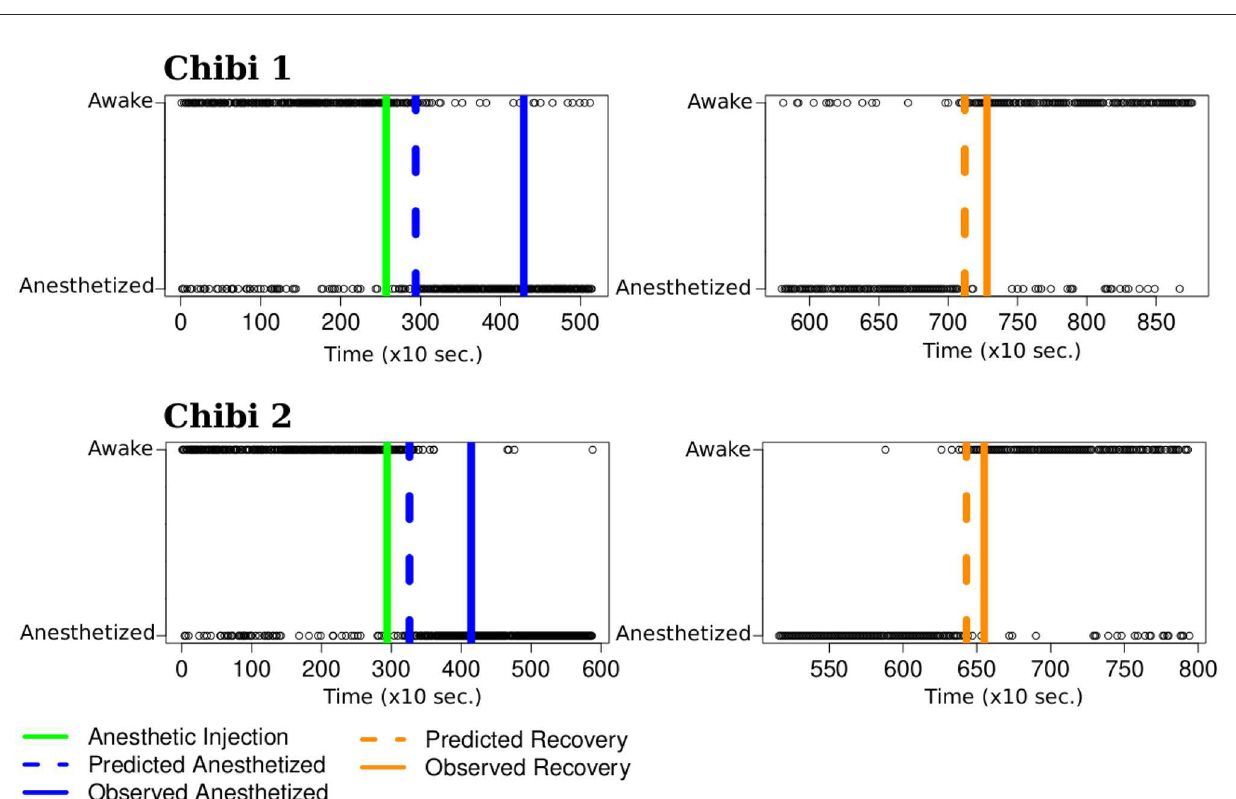
FIGURE6 Mental state transition time point. The x and y axes represent the time (in 10 seconds) and the monkey’s state. The green line represents the moment of the anesthetic injection. The solid blue line represents when the researcher certifies the monkey stops responding to physical stimuli. The solid orange line represents when the researcher certifies the monkey starts responding again. The black circles are the k-means clustering predictions for the monkey’s mental state. We estimate the moment the monkey changes its mental state using a centered moving average. On the left panels , it is the time point where the moving average is less than 0.5 (blue dashed line), and on the right panels , it is the time point with a moving average greater than 0.5 (orange dashed lines). The predicted changing points occur before the researcher certifies the transition state, suggesting a better prediction from the ECoG signal than the empirical